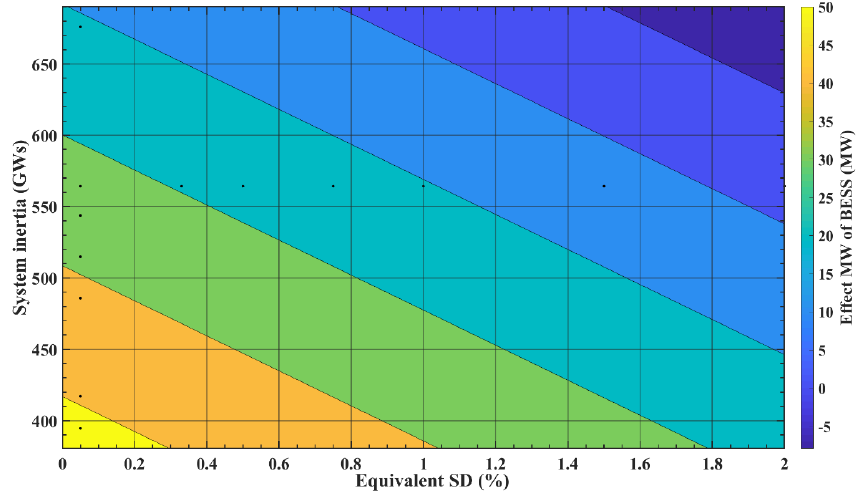
Figure 12. Analysis of BESS Effect MW depending on operation condition.